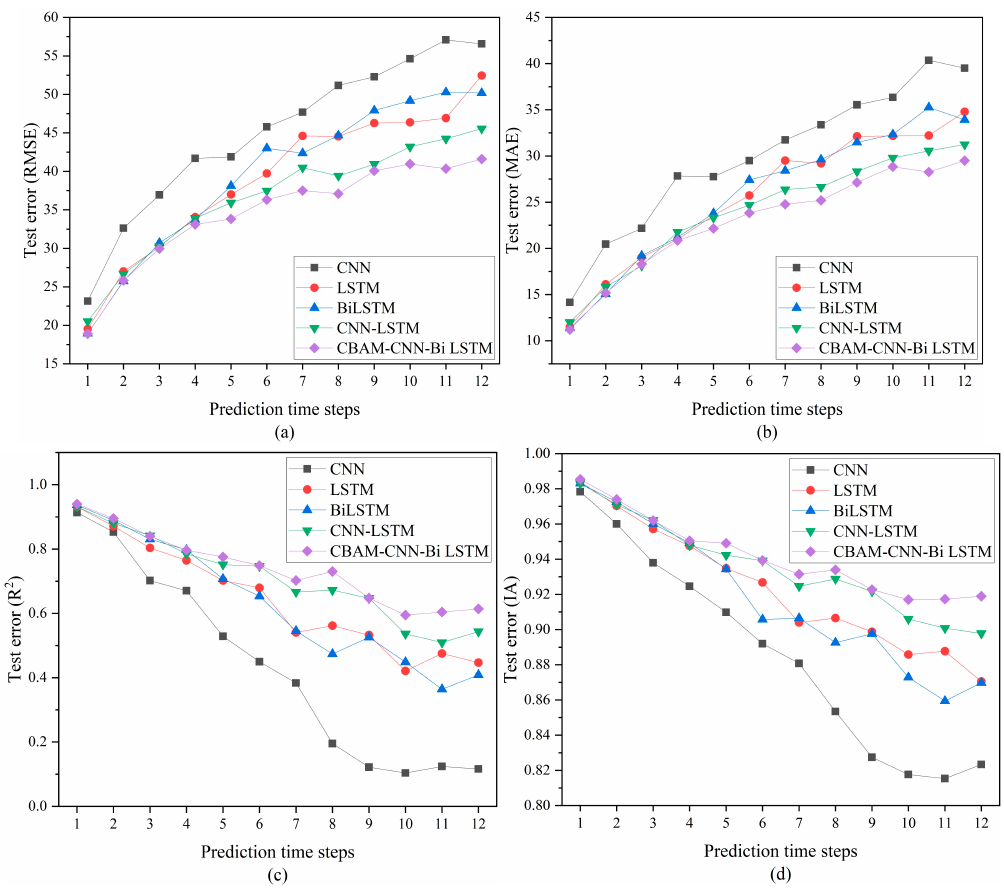
Figure 7. RMSE, MAE, R 2 , and IA of the CBAM-CNN-Bi LSTM model at different prediction time steps and comparisons with other deep learning models. ( a ) RMSE of models at different prediction steps. ( b ) MAE of models at different prediction steps. ( c ) R 2 of models at different prediction steps. ( d ) IA of models at different prediction steps. Table 5. Performance evaluation indicators for model prediction (h13–h18).